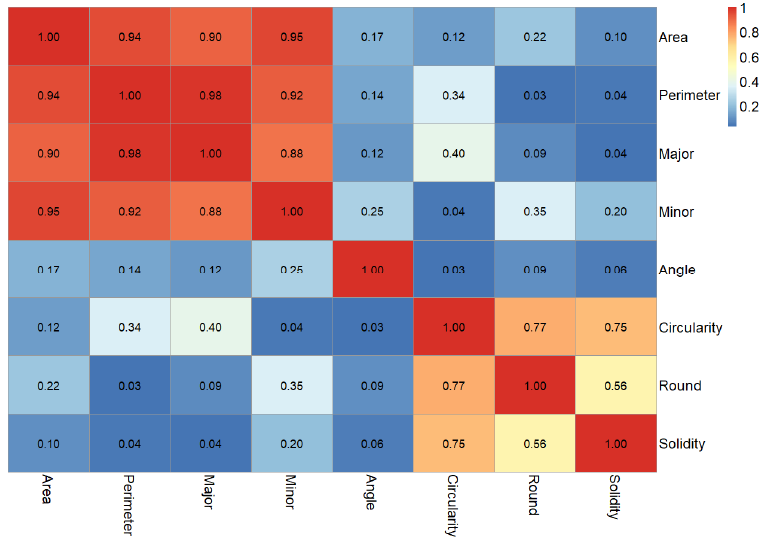
Figure 7. Heat map of correlation coefficient result.